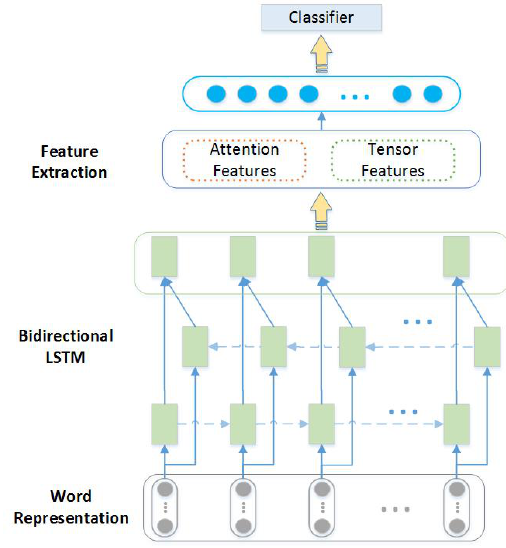
Fig. 1 The architecture of our